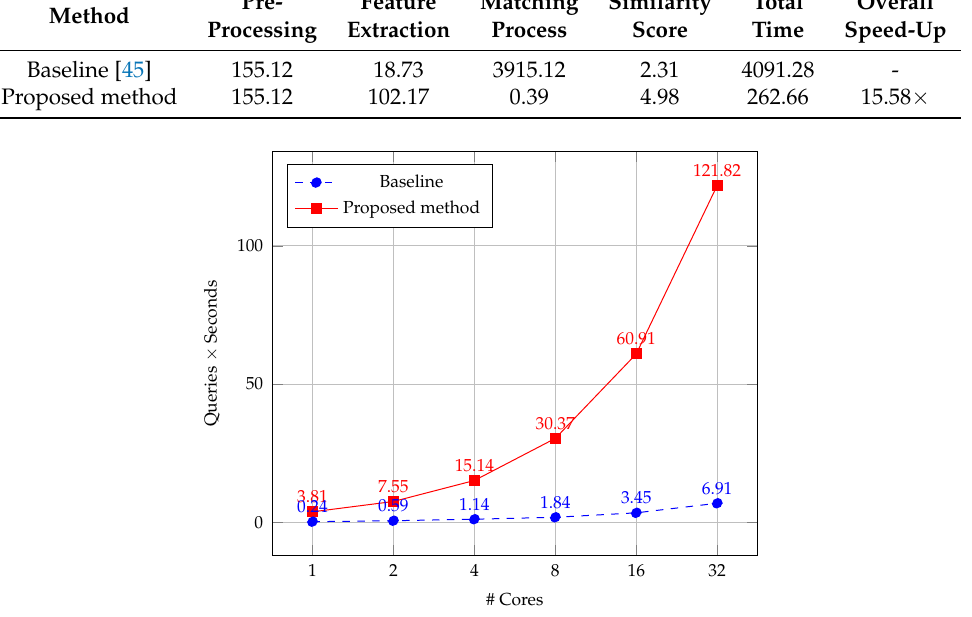
Figure 10. Results of queries per seconds computed by both methods on different number of cores. Number 1 means the sequential